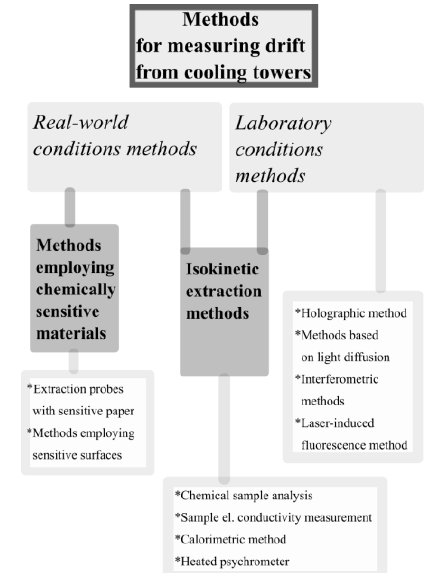
Fig. 1. The state of the art methods for measuring drift from cooling